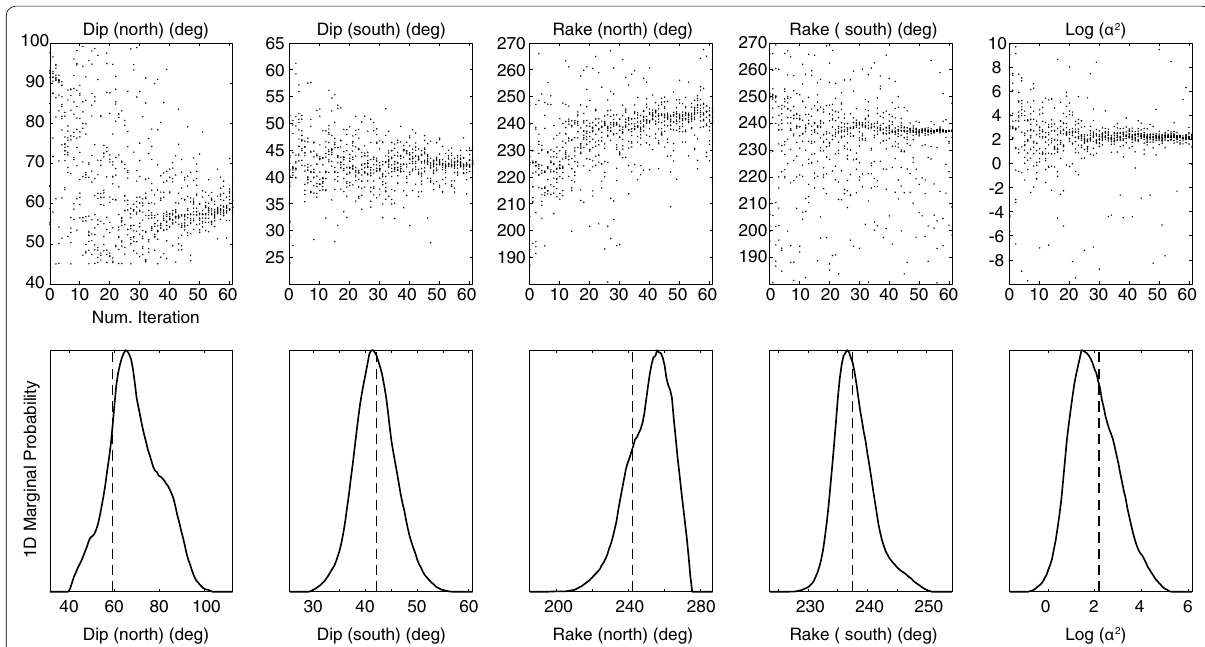
Fig. 7 (Top) Number of iteration against nonlinear parameter values, showing the convergence of the PSO optimization. (Bottom) One-dimensional marginal posterior probability distribution of the model